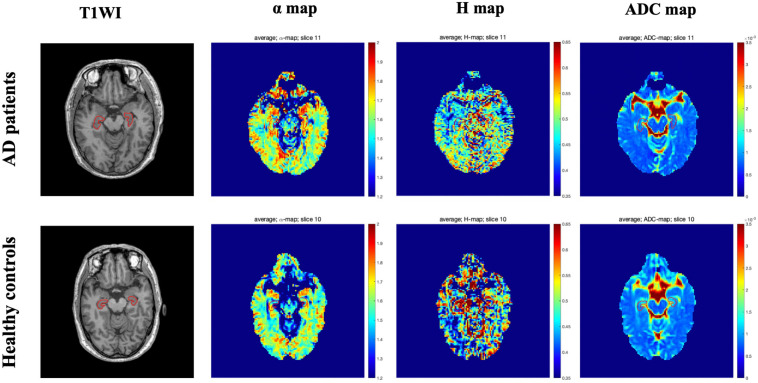
Representative axial T1 weighted imaging and FM-related parameters maps from one AD patient (top row, a 58-year-old male) and one healthy control (bottom row, a 60-year-old male). The bilateral hippocampus are shown with red outlines in all maps. FM, fractional motion; AD, Alzheimer’s disease.